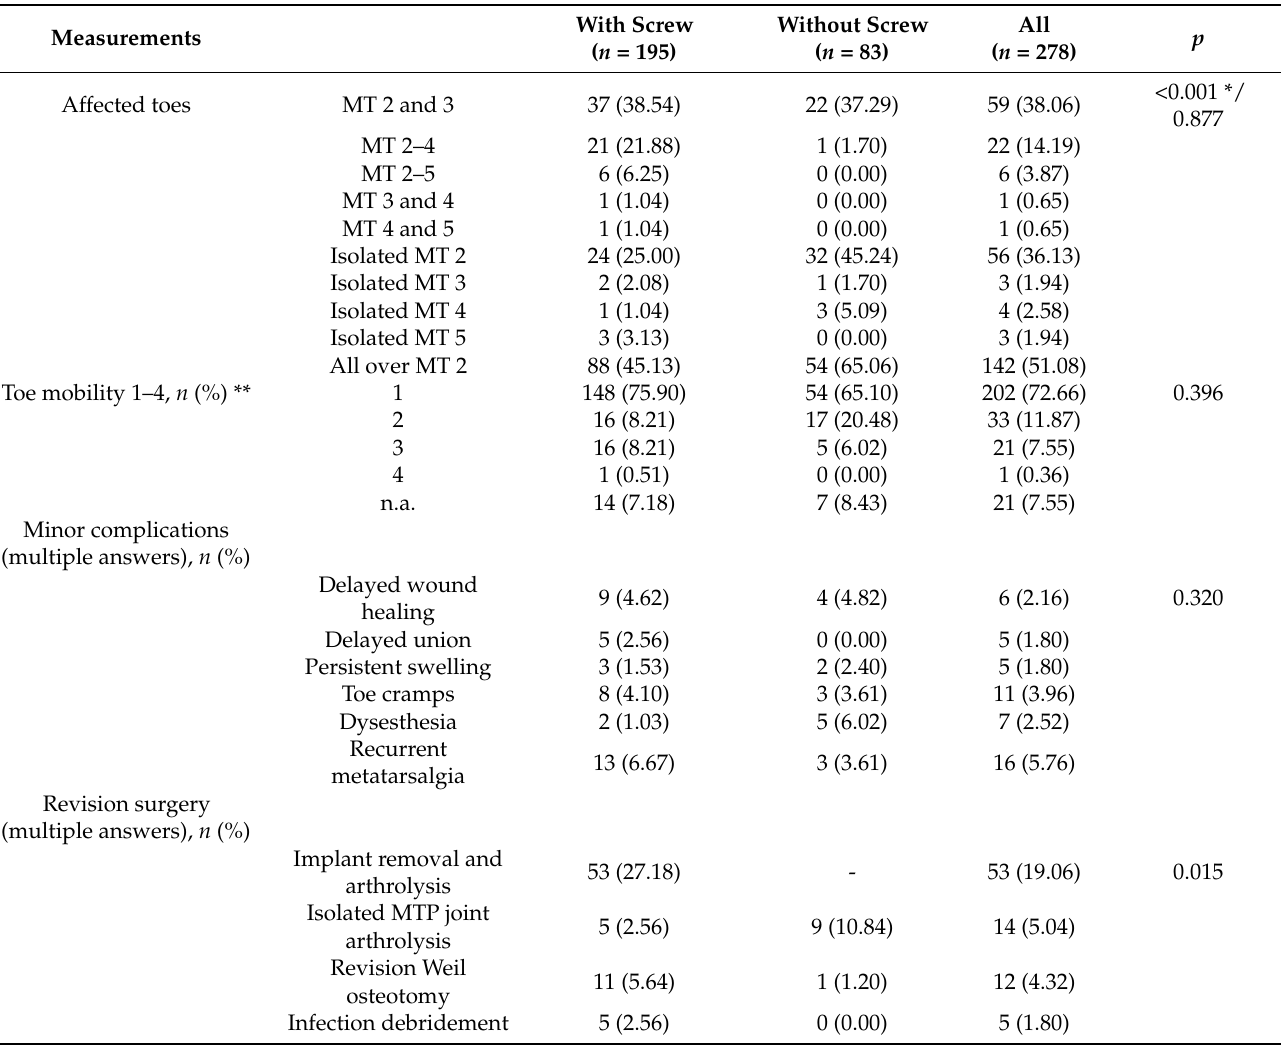
Table 3. Clinical outcome according to treatment, based on the number of treated